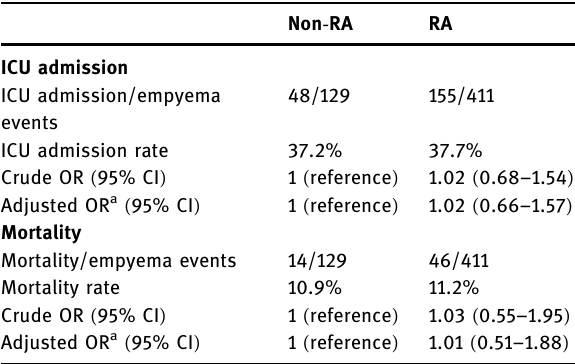
Table 4: ICU admission rate and 30 - day mortality rate of empyema for patients with RA compared to those without RA